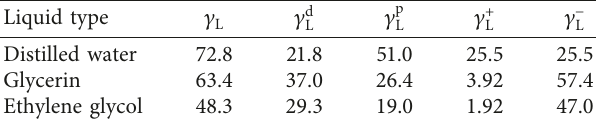
Table 4: Surface free energy parameters of three fluids (mJ/m 2 ).